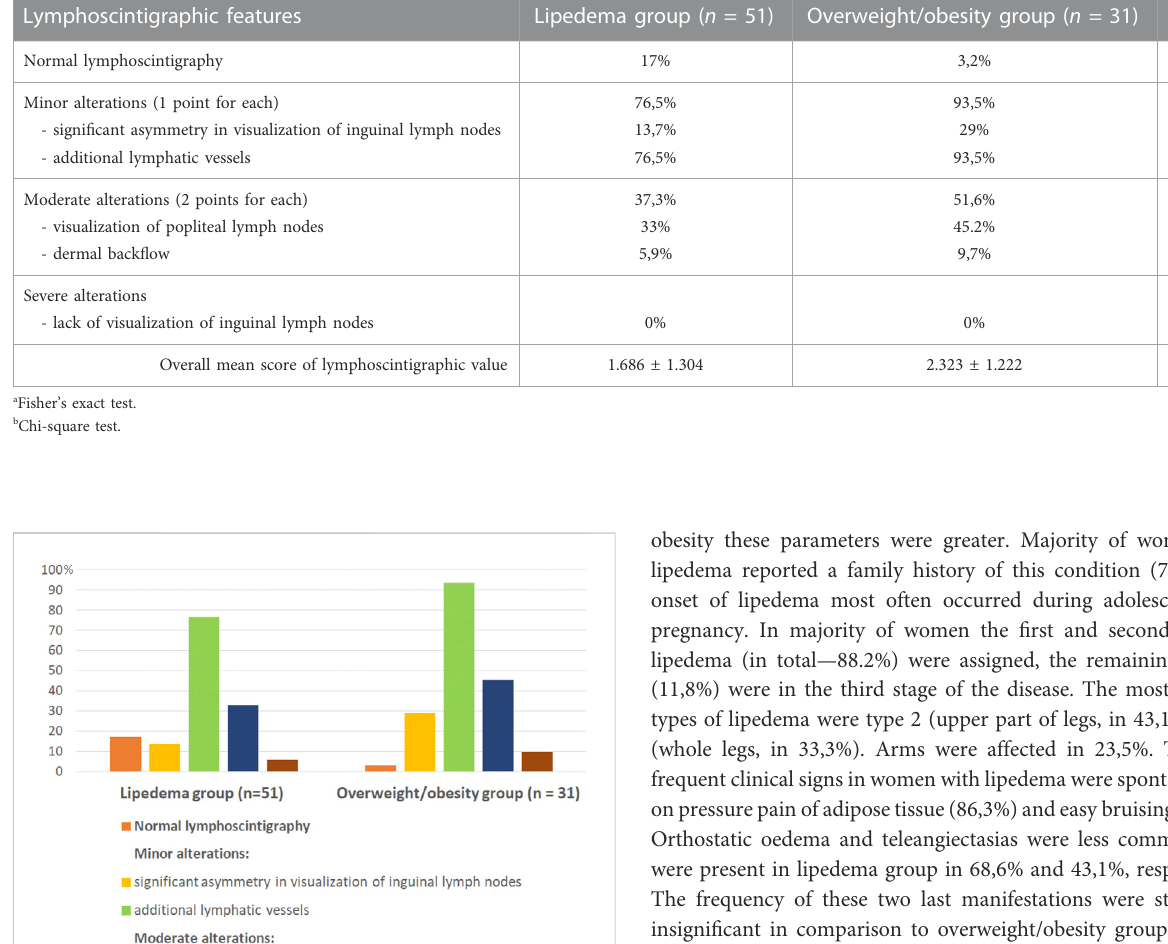
TABLE 3 Lymphoscintigraphic alterations in groups with lipedema vs. overweight/obesity. Lymphoscintigraphic features